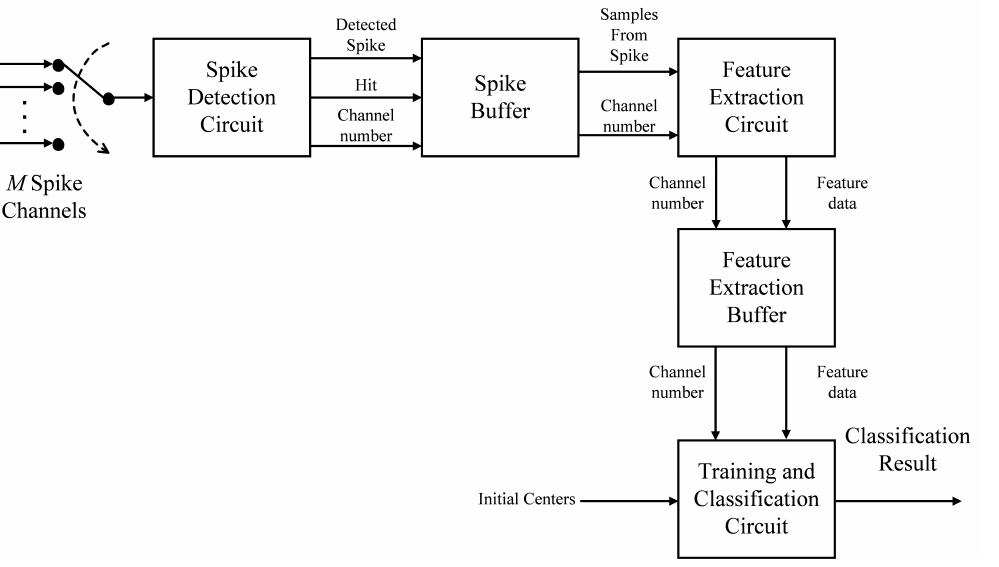
Figure 1. The block diagram of the proposed circuit. It contains five components: spike detection circuit, spike buffer, feature extraction circuit, feature extraction buffer and training and classification